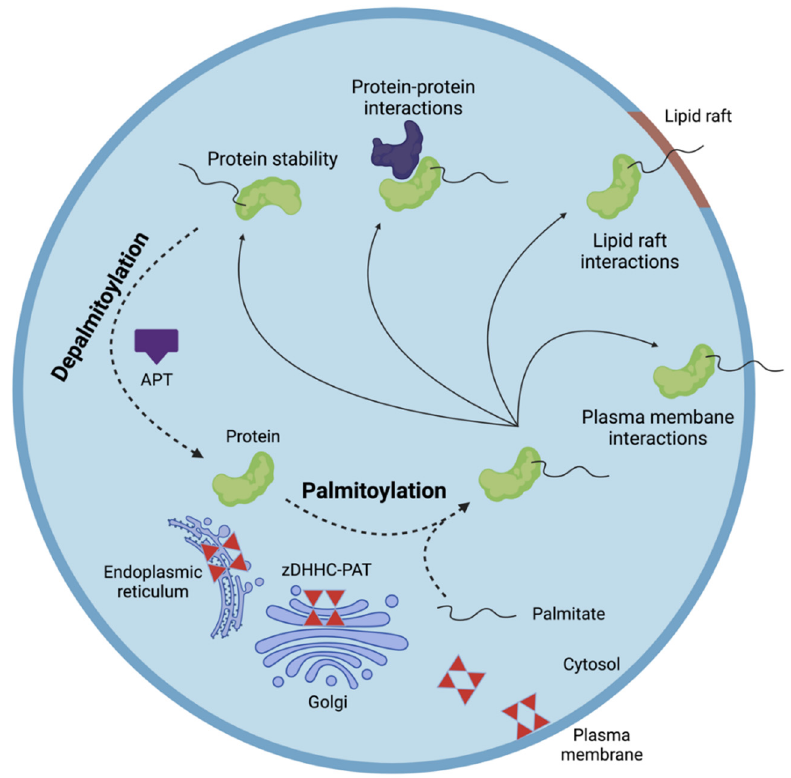
Figure 1. Dynamic protein S-palmitoylation. S-palmitoylation is a reversible and dynamic post- translational protein modification that is mediated by protein acyl-transferases (zDHHC-PAT) and acyl protein thioesterases (APTs) that attach to and remove palmitate from protein cysteine residues, respectively. S-palmitoylation controls protein activity, stability, trafficking, and protein–protein interactions. Figure created with BioRender.com (accessed on 9 January 2022).